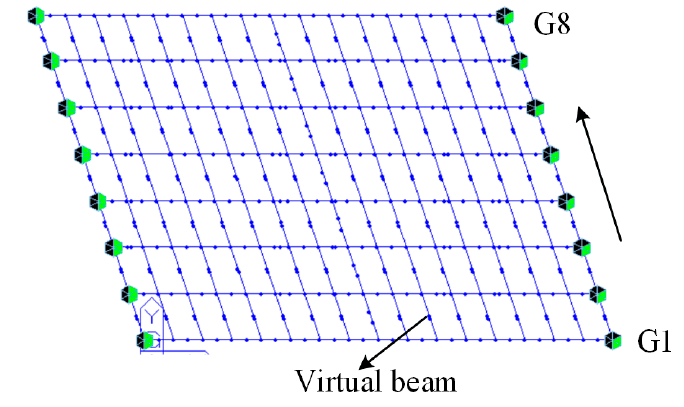
Figure 8. FE model.